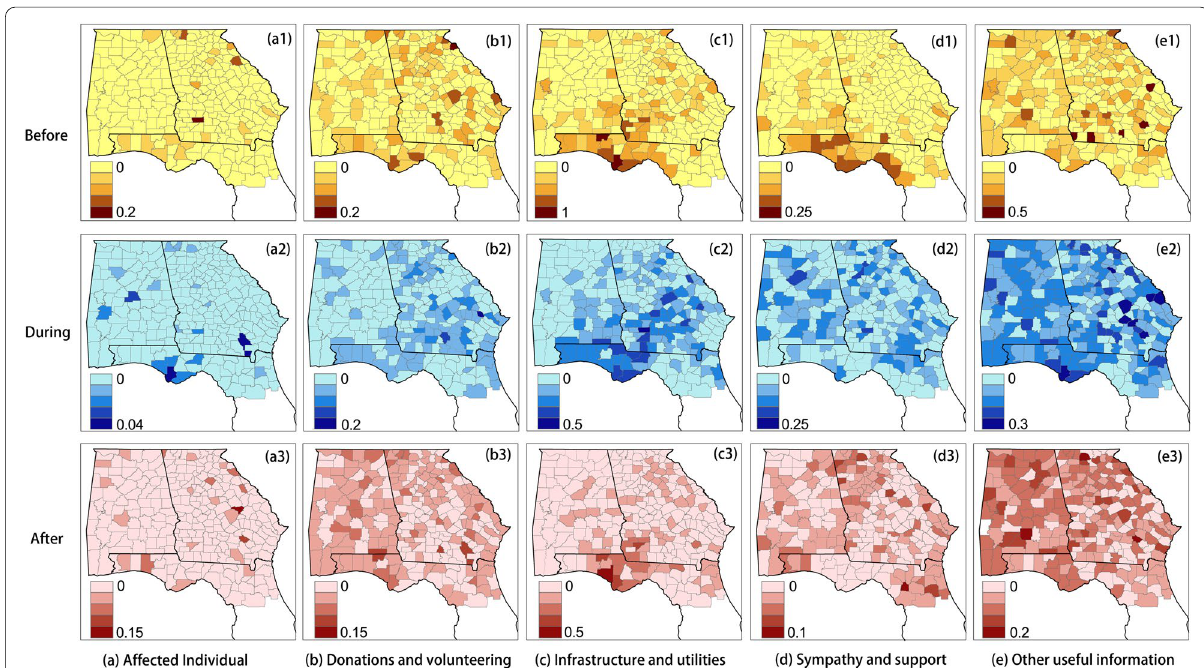
Fig. 5. Spatial distribution of humanitarian-level situational awareness before, during, and after the